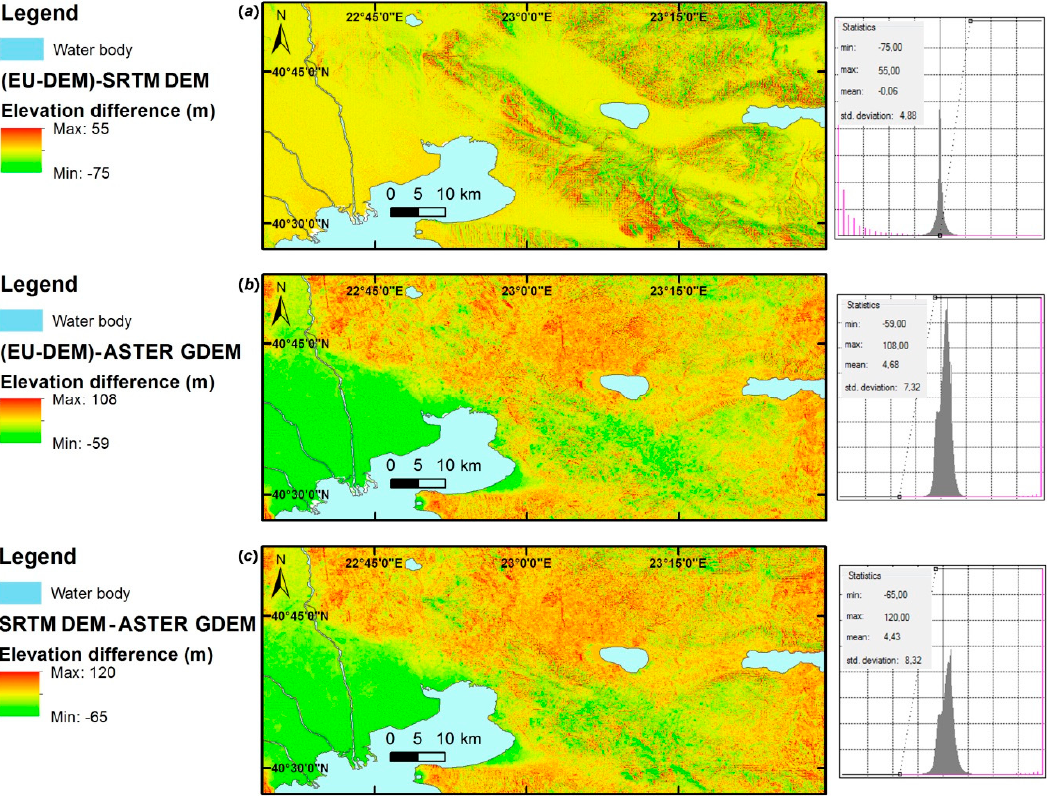
ISPRS Int. J. Geo-Inf. 2019 , 8 , x FOR PEER REVIEW Figure 2. Elevation comparison by subtraction of corresponding pixel values, between the original version of EU-DEM (v1), SRTM DEM and ASTER GDEM in the area of interest: ( a ) (EU-DEM) – SRTM DEM, ( b ) (EU-DEM) – ASTER GDEM and ( c ) SRTM DEM – ASTER GDEM.